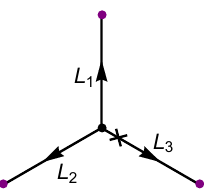
Figure 3 . A correlation functional (on the plane), where the TDLs are joined by a T-junction (black dot) with the order of lines speci(cid:12)ed (last leg marked by the \ (cid:2) "), and ending on defect operators (purple dots). It is a linear function on the junction vector space V L . 1 ; L 2 ; L 3 IR TQFT becomes larger than in the UV CFT. 6 For such a TQFT, we de(cid:12)ne the junction vector space V as the subspace of weight-(0 ; 0) topological defect operators L 1 ; L 2 ; (cid:1)(cid:1)(cid:1) ; L k